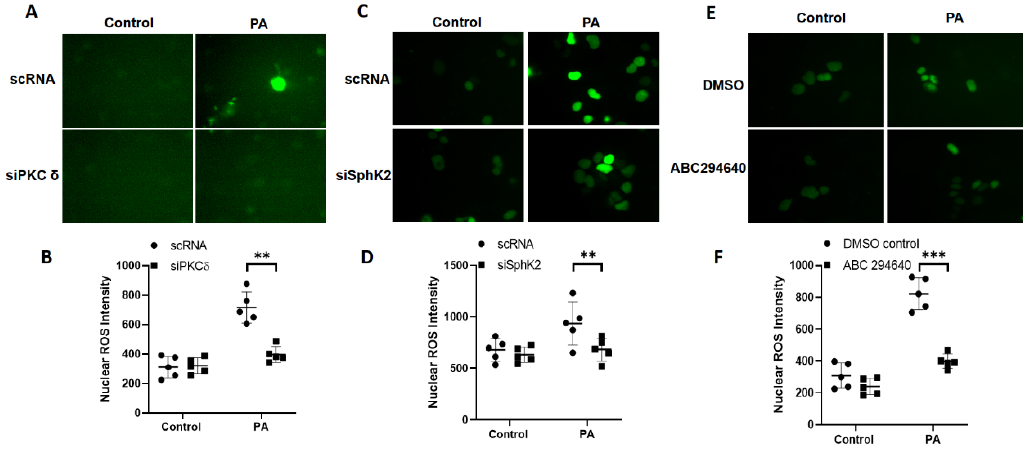
Figure 5. NOX4 inhibitor, Setanaxib (GKT 137831), attenuates P. aeruginosa -induced nuclear ROS in lung epithelial cells. Mouse lung epithelial (MLE12) cells grown in 35 mm glass-bottom dishes (~90% confluence) were transfected with control or nuclear-HyPer plasmid (50 nM) for 24 h. Cells were pretreated with NOX4/NOX1 inhibitor, Setanaxib (GKT 137831) (5 μ M), for 1 h followed by heat-inactivated P. aeruginosa (PA) (1 × 10 8 CFU/mL) challenge for 3 h. Nuclear ROS (hydrogen peroxide) production was detected by live imaging of cells using a confocal microscope ( A ) and quantified by NIH Image J software ( B ) Shown is a representative image from three independent experiments, and values are means ± SD from three independent experiments. ** p < 0.001.